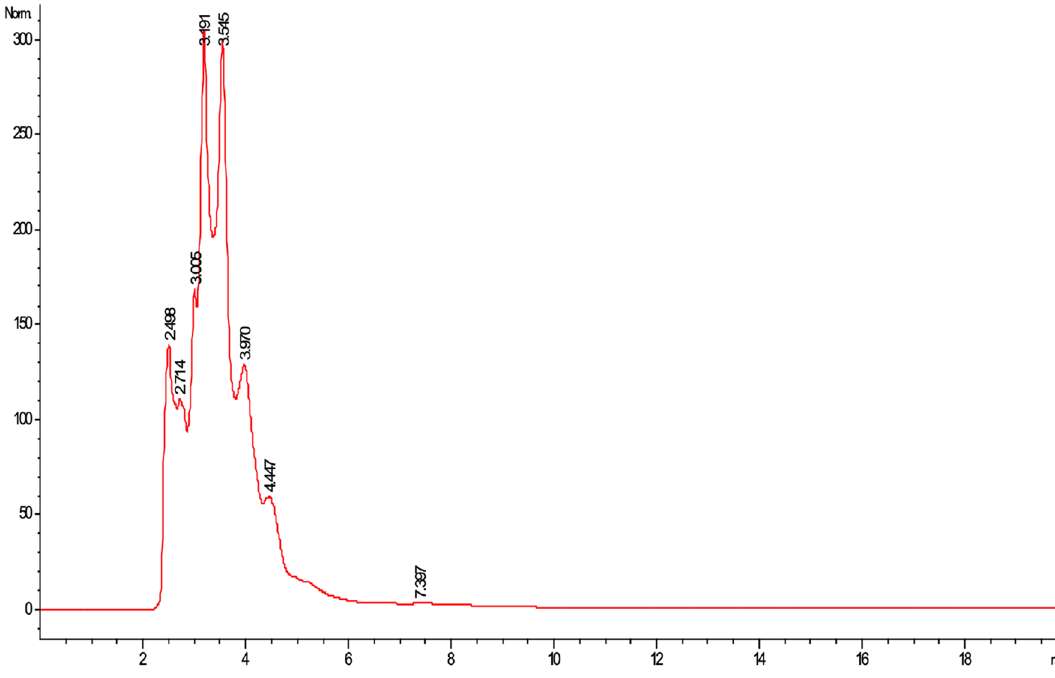
Figure 1. Chromatogram of Prosopis laevigata methanolic leaf extract obtained by